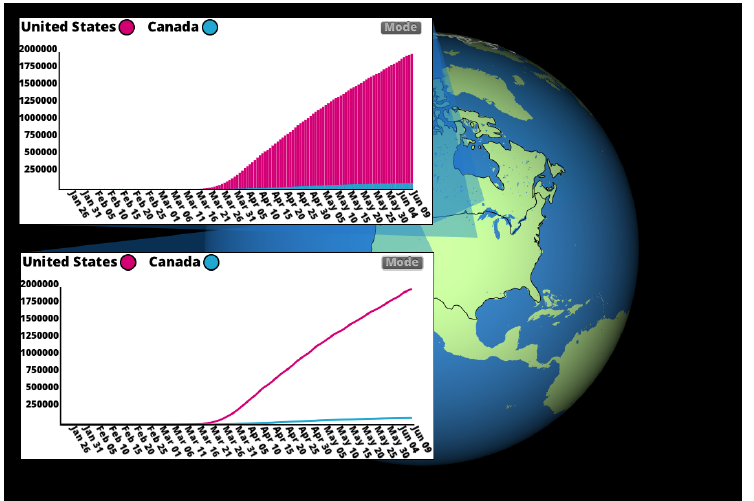
Figure 5. Multiple regions’ data displayed in one chart in the COVID-19 Visualization project. Multivariate charts can be displayed using either bar charts or line charts.